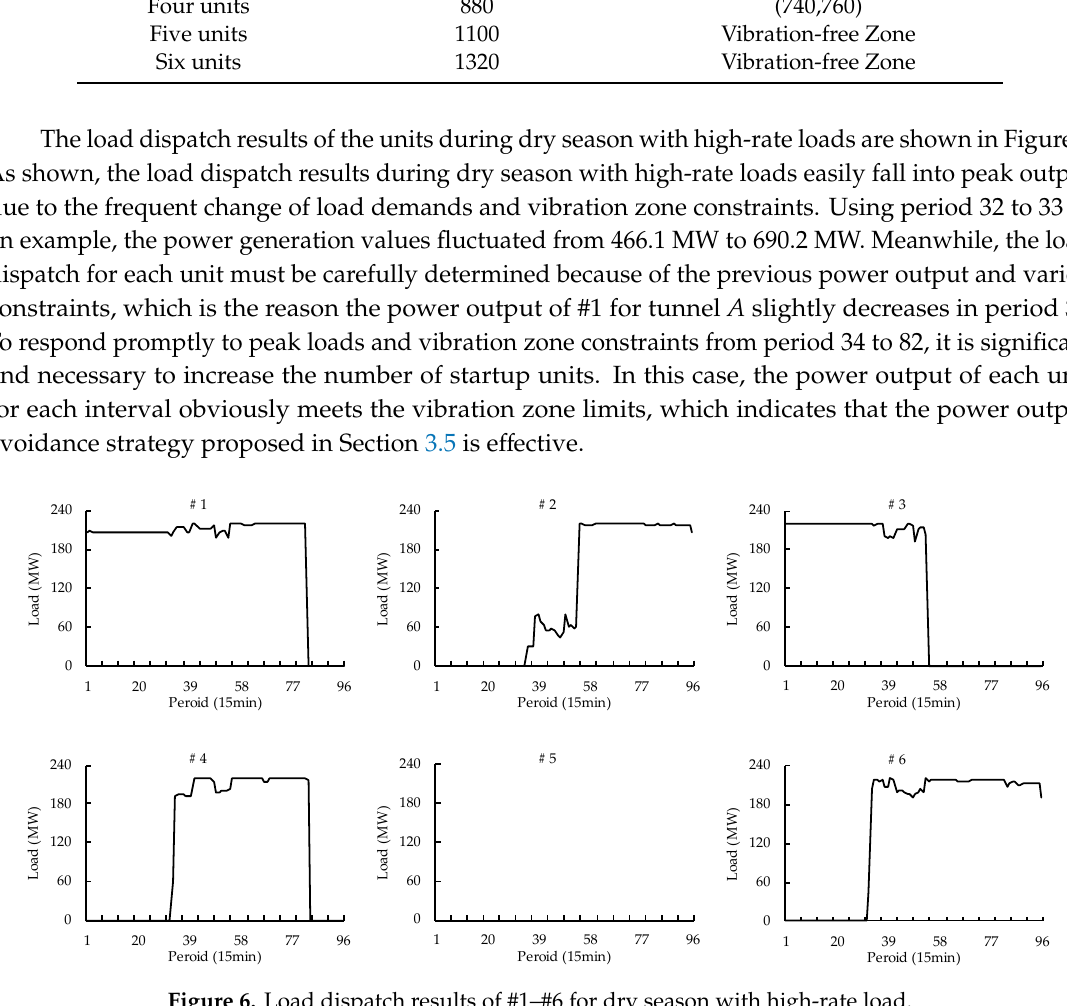
Figure 6. Load dispatch results of #1–#6 for dry season with high-rate load.